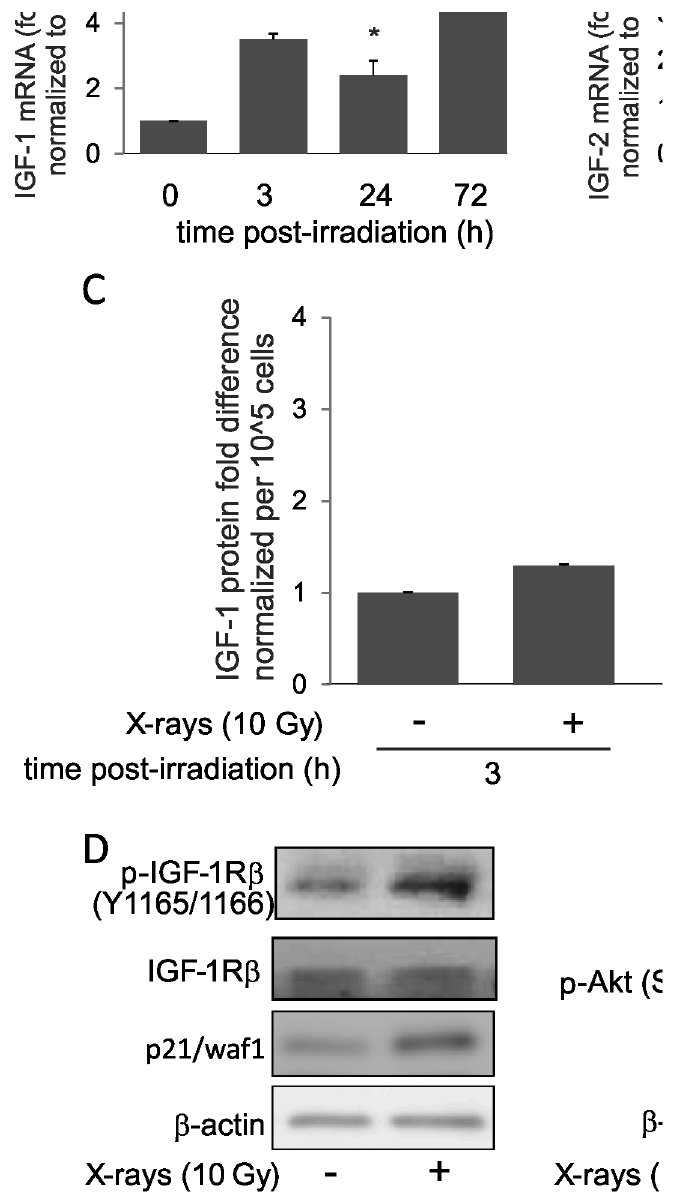
Figure 2. Induction of IGF-1R signaling in irradiated HPAEC. (A and B) IGF-1 and IGF-2 mRNA levels in irradiated HPAEC were assessed by qPCR at indicated time-points post-irradiation. The mRNA levels were normalized to GAPDH. Graph represents means ± SD, n = 3. * indicates statistical significance from controls, p < 0.05. (C) IGF-1 levels in secreted medium were measured by ELISA at indicated time-points post-irrradiation. Graph represents means ± SD, n = 3. * indicates statistical significance from controls, p < 0.05. (D) Western blotting for expressions of proteins involved in IGF-1R hyperphosphorylation (left panel) and Akt hyperphosphorylation (Ser 473, right panel) at 3 hours post-irradiation. doi: